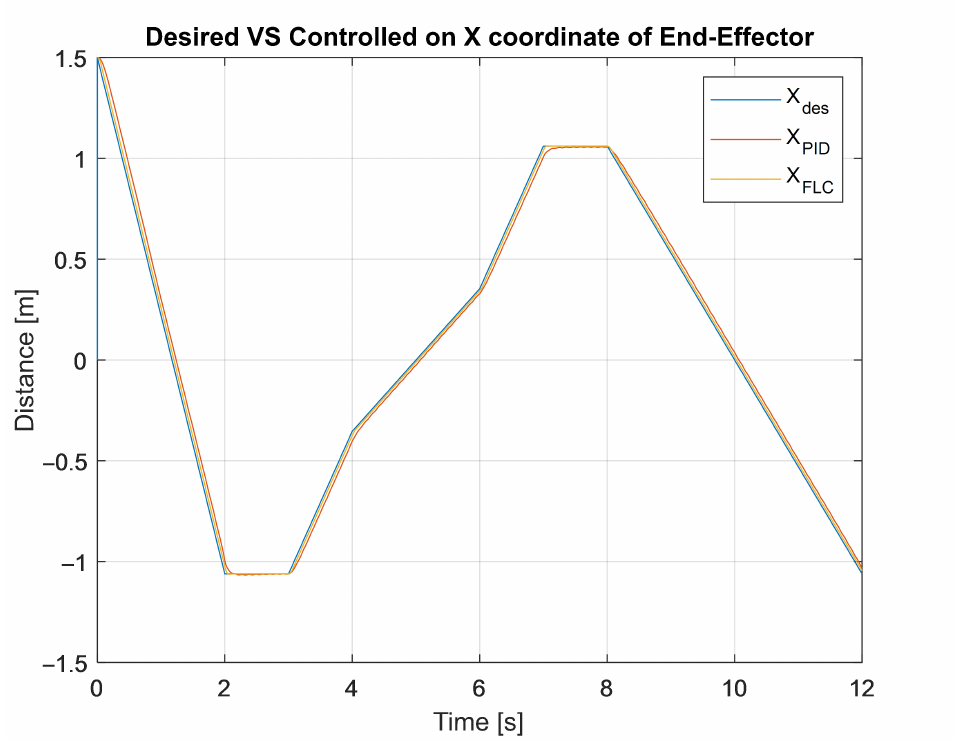
Figure 9. Trajectory tracking result for X component of end-effector position.